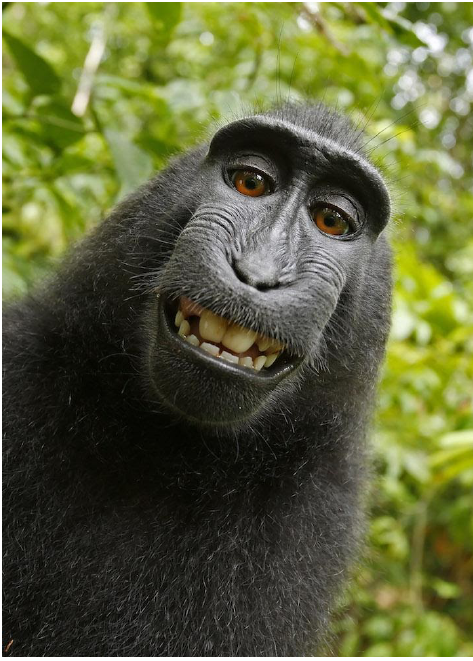
Figure 1: Monkey selfie